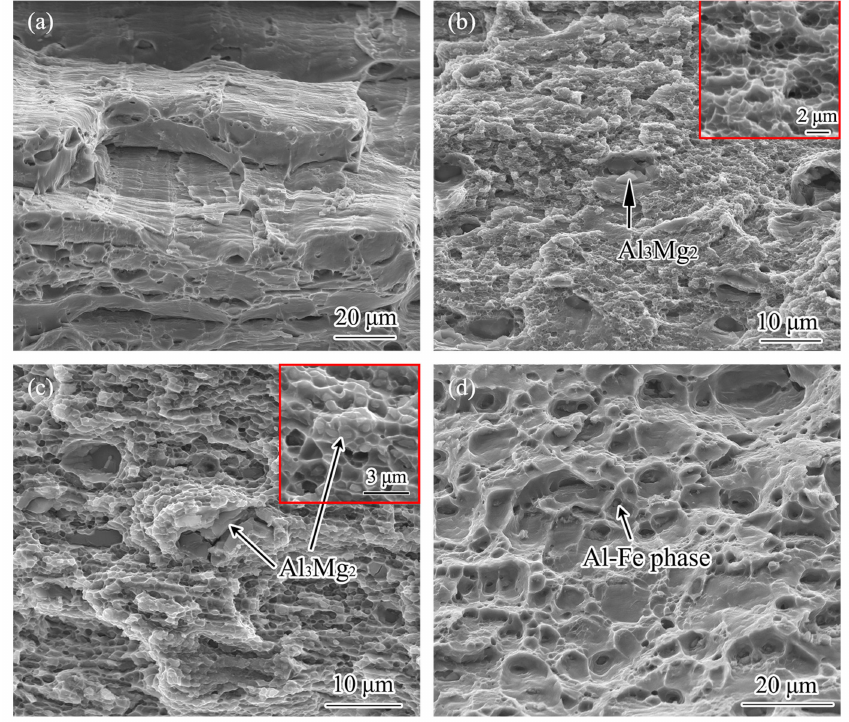
Figure 8. Secondary SEM fracture morphology of Al–10Mg alloy annealed at ( a ) cold-rolled, ( b ) 200 ◦ C, ( c ) 300 ◦ C and ( d ) 400 ◦